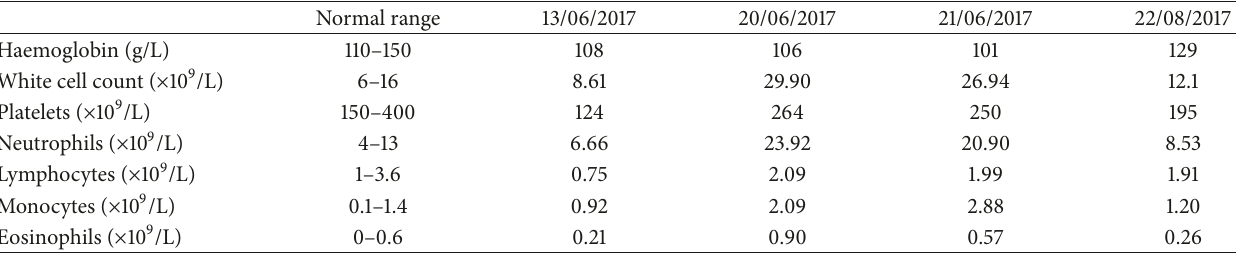
Table 1: Serial blood result chart (normal ranges from 2nd trimester [5]).